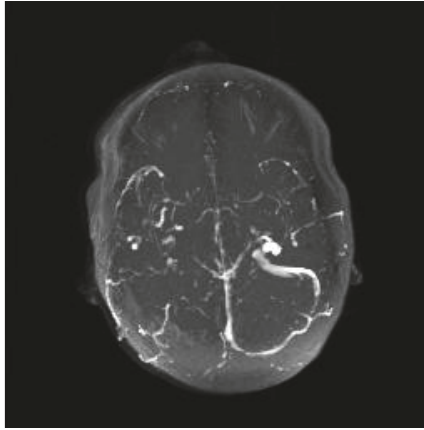
Figure 6: MRV demonstrates absence of flow in the superior sagittal, right transverse, and right sigmoid sinuses in our patient.